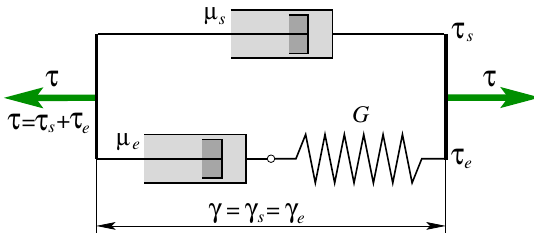
Figure 1. Mechanical analogue for the Johnson–Segalman